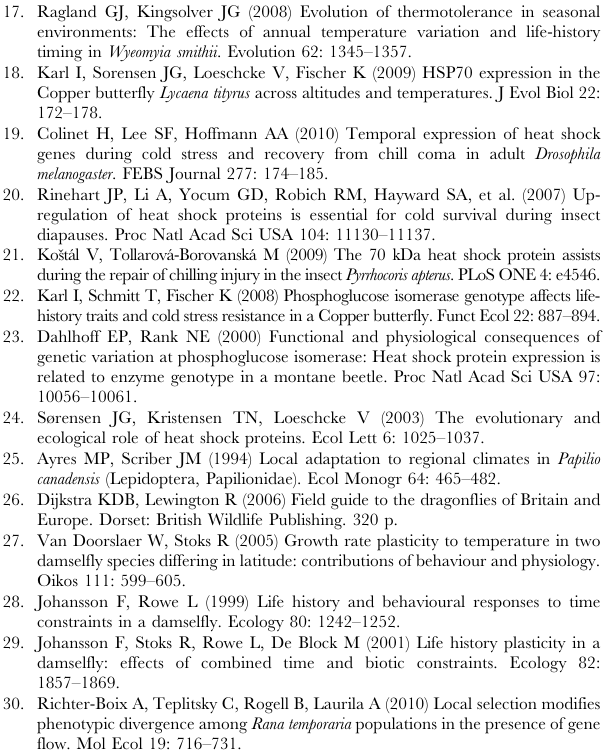
Figure S1 Differences in development time and mass at emergence between latitudes across temperatures. Mean ( 6 1 SE) larval development time (A), and mass at emergence (B) of Ischnura elegans from the two northern and two southern populations at the three rearing temperatures. Means are slightly offset to aid visualization.